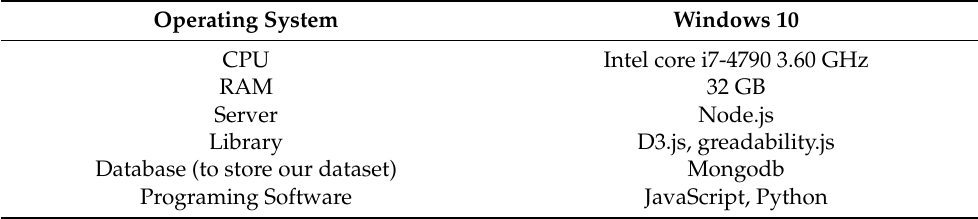
Table 1. System environment.